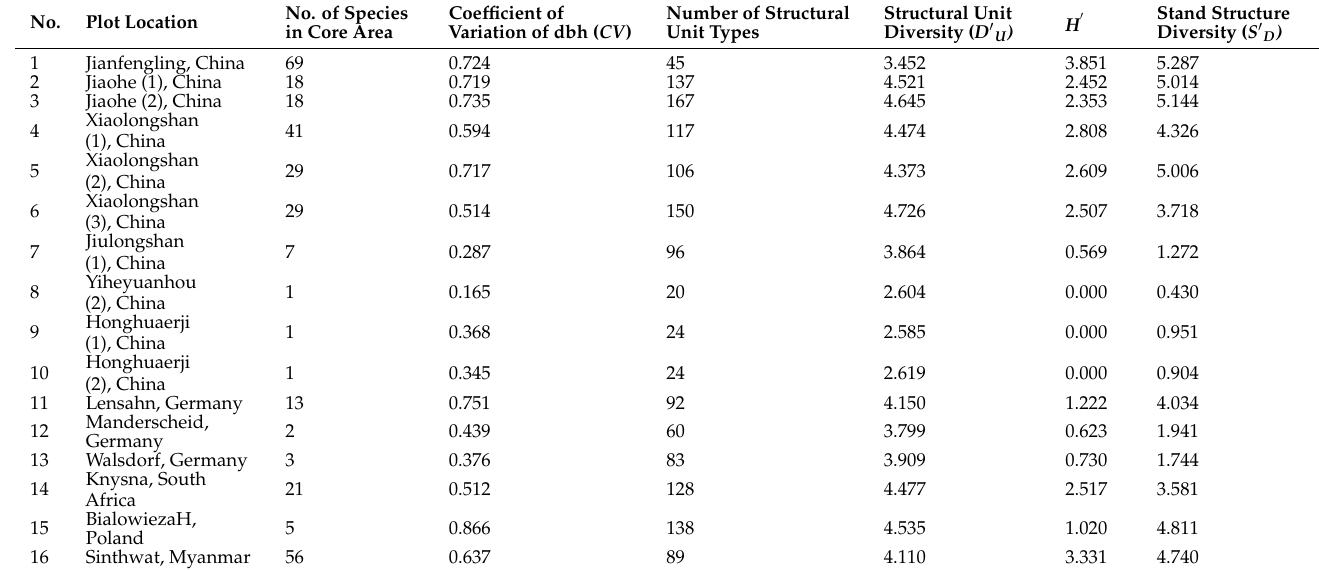
Table 5. Measures of stand structure diversity of 16 different forest